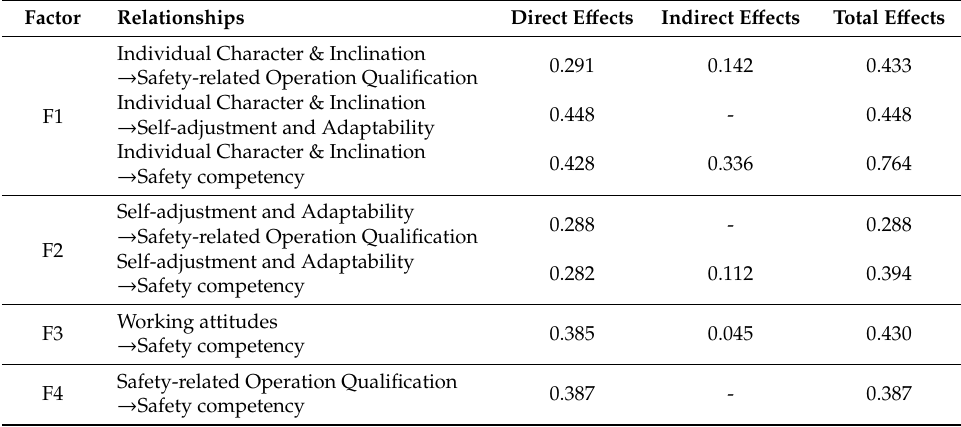
Table 12. Direct, indirect, and total e ff ects of latent